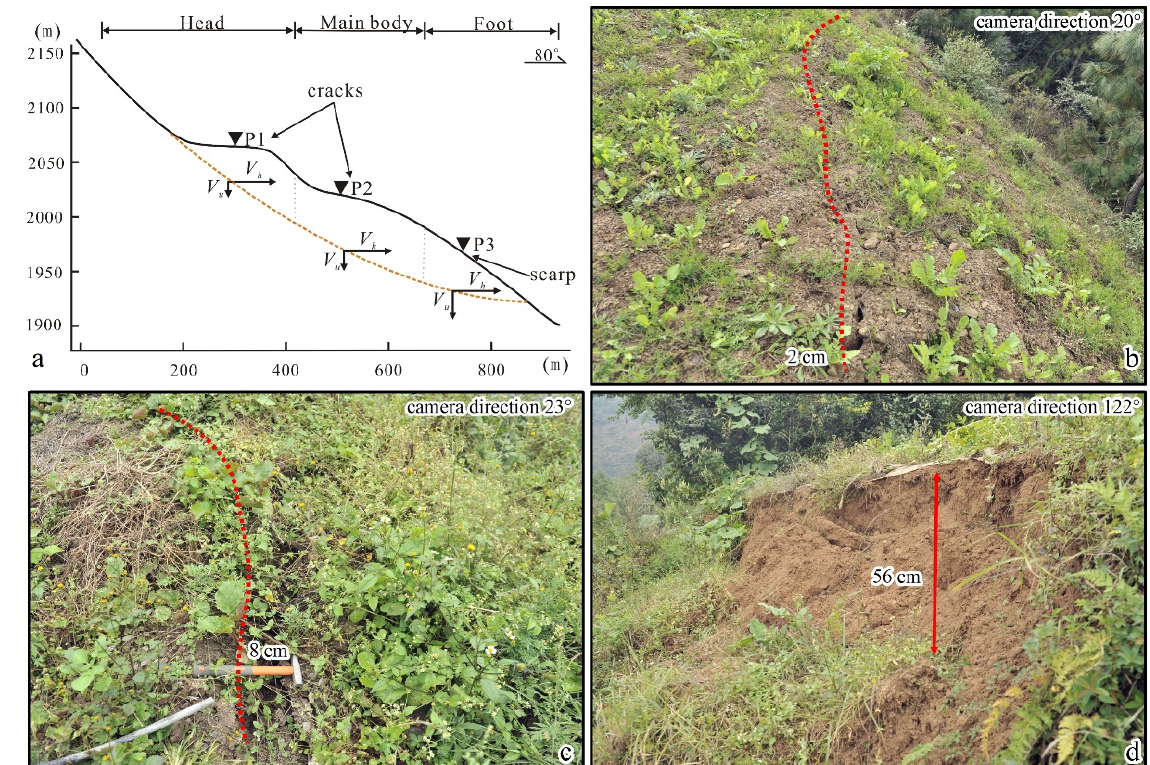
Figure 11. ( a ) Landslide profile II-II’ and location of field survey points; ( b ) deformation in the head of HJP landslide (corresponding to point P1); ( c ) tension cracks in the main body of HJP landslide (corresponding to point P2); ( d ) tension cracks and small collapse at the foot HJP landslide (corresponding to point P3).